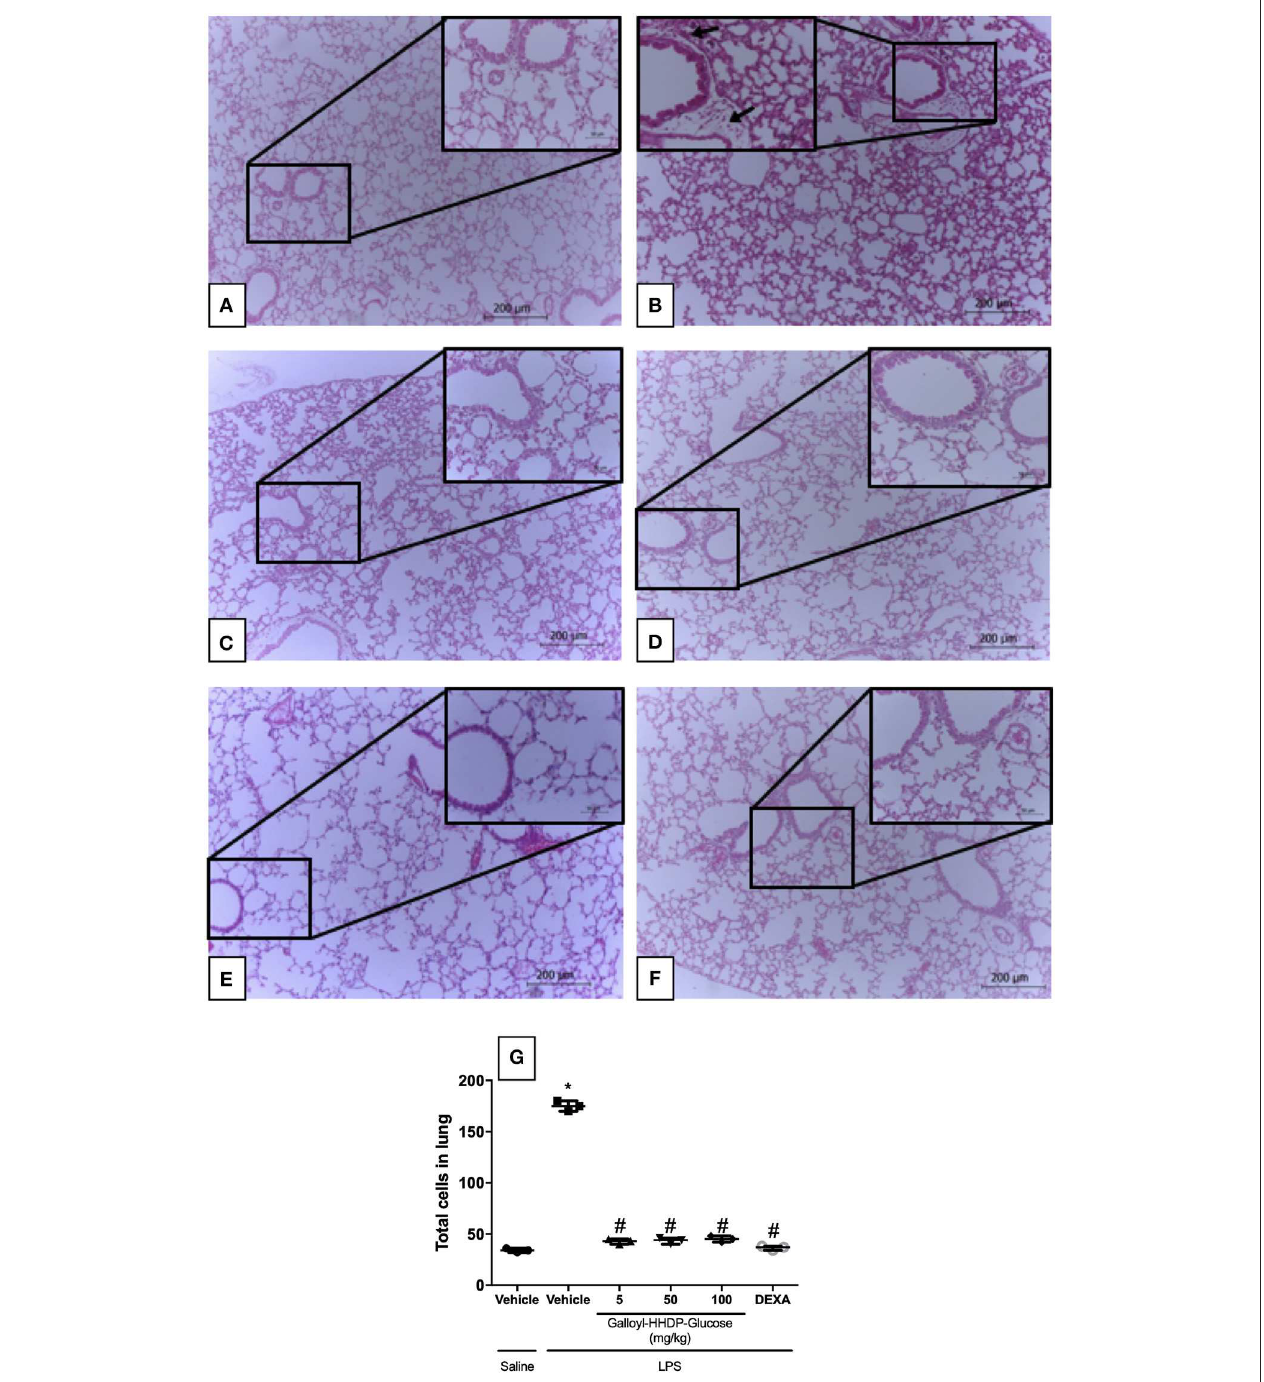
FIGURE 6 | Effect of galloyl-HHDP-glucose treatment on leukocyte accumulation in the lungs of mice treated with saline-injected non-treated mice (A) , lipopolysaccharide (LPS)-installed non-treated mice (B) , 5 mg/kg galloyl-HHDP-glucose and LPS (C) , 50 mg/kg galloyl-HHDP-glucose and LPS (D) , 100 mg/kg galloyl-HHDP-glucose and LPS (E) , 5 mg/kg dexamethasone and LPS (F) , and total cells in lung (G) . Black arrows: bronchiolar inflammatory cell infiltrates. Sections (4 µ m) were stained with hematoxylin and eosin, and viewed with a microscope at 100x and 400x magnification respectively. Significances were calculated by One-way ANOVA followed by Tukey test analysis of the groups vs. saline-injected non-treated mice (* p < 0.05) and vs. lipopolysaccharide (LPS)-installed non-treated mice ( # p < 0.05).